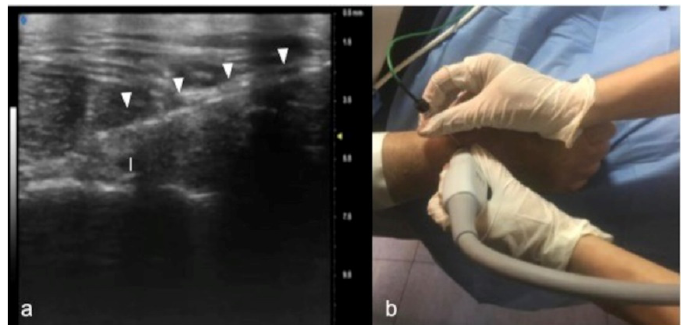
Figure 10. Percutaneous radiofrequency ablation of the posterior interosseous nerve for chronic wrist pain: In ( a ), cannula’s insertion (white arrowheads) under real-time ultrasound. Guidance for direct visualization of the posterior interosseous nerve (white caliber). The procedure is performed on an awake patient using a noninvasive approach ( b ).